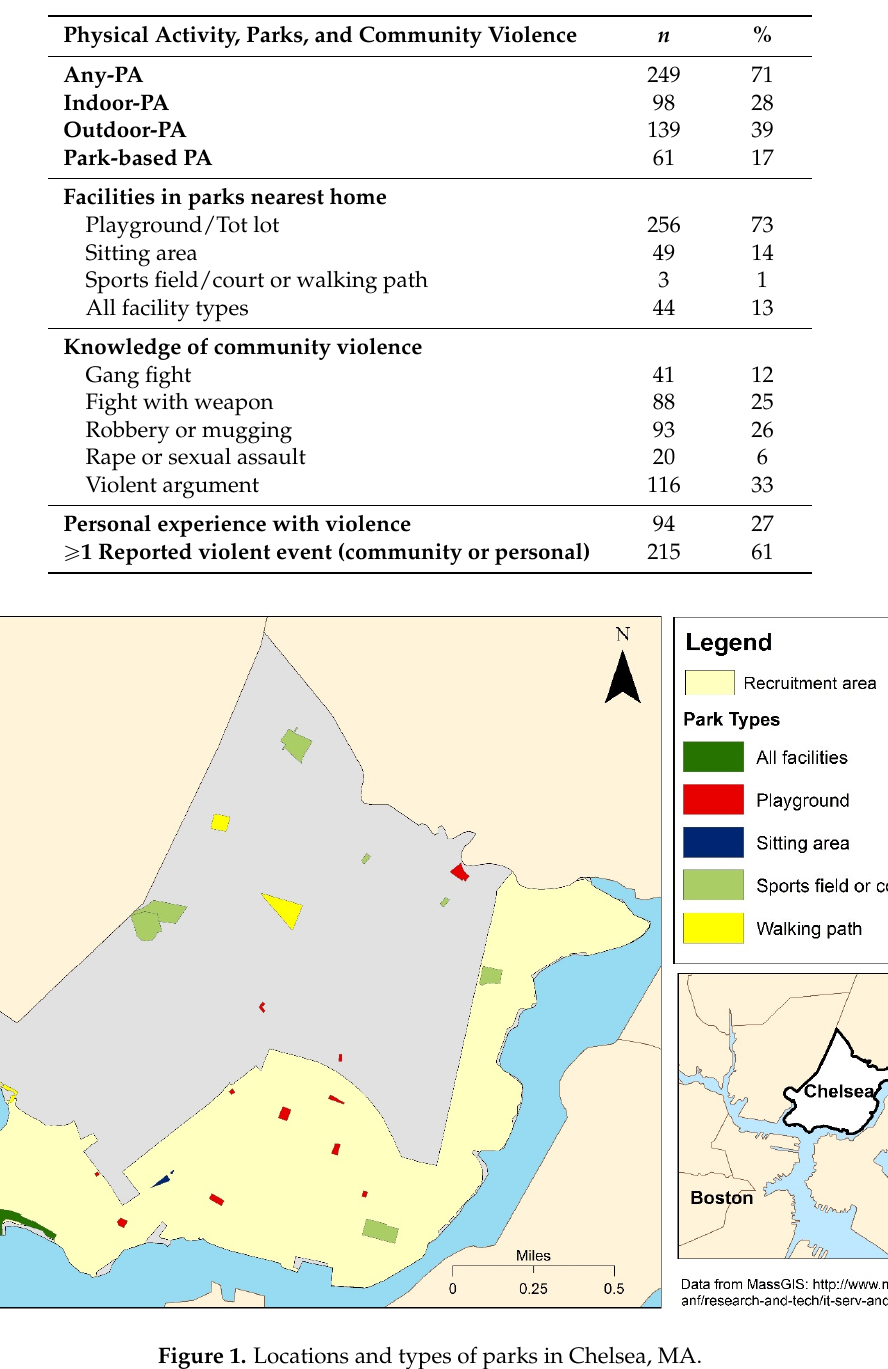
Table 2. Number and percent of reported physical activity (PA), local park types near home, and knowledge of community violence among the 352 study participants.